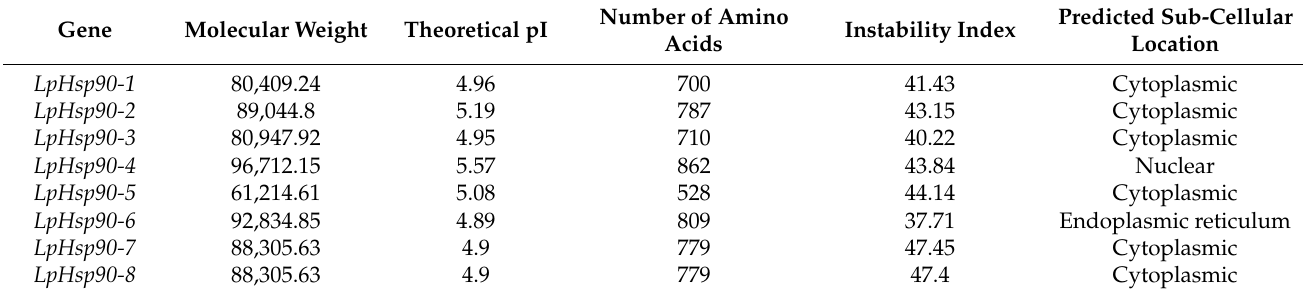
Table 1. The biophysical characteristics and subcellular localization of Lphsp90